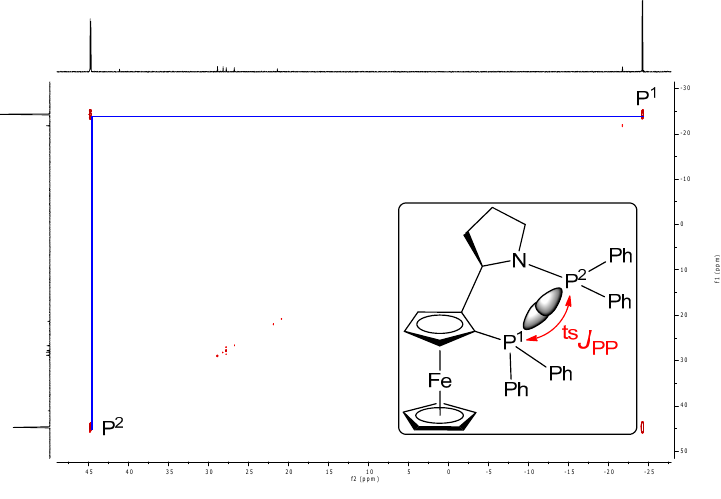
Figure 4. Series of novel ligands L1 – L8 prepared. Interestingly, 5 J coupling between the phosphorus atoms was observed for ligands L1 – L6 with coupling constants ranging from 16.4 to 56.2 Hz. Cross peaks in the two-dimensional 31 P{ 1 H}– 31 P{ 1 H} spectra ( 31 P COSY) provided further evidence for this unexpected interaction (Figure 5). Although ‘long range couplings’ (across more than four bonds) between two phosphorus atoms are quite rare, the phenomenon has been observed with several ligands, such as Xantphos ( 6 J coupling) and tetraphosphine ferrocenyl derivatives [29]. An excellent in-depth study of the ferrocenyl compounds attributed the 31 P– 31 P nuclear spin-spin coupling to a through-space non-bonded interaction of the phosphorus lone pairs, as was previously observed in 19 F– 19 F and 15 N– 19 F couplings [30]. Due to the magnitude of the coupling constants observed for L1 – L6 , it is unlikely a through-bond interaction ( σ - and π -transmitted components) is taking place. Through-space coupling results from overlap of the phosphorus lone-pair orbitals. Although the interaction provides an adequate pathway to transmit spin information between the nuclei, it does not lead to chemical bonding because both orbitals are occupied.